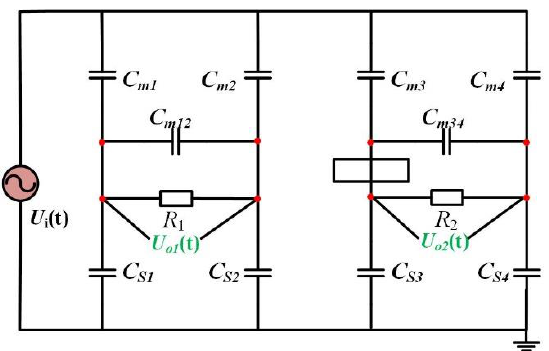
ff erential D-dot overvoltage